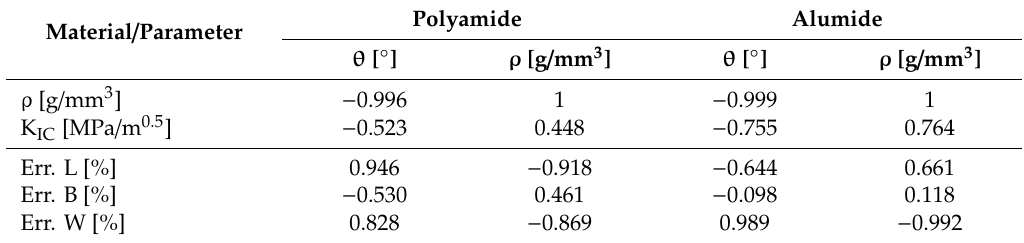
Table 2. Pearson’s correlation between sample orientation, density, size and fracture toughness. Polyamide Alumide Material / Parameter θ [ ◦ ] ρ [g / mm 3